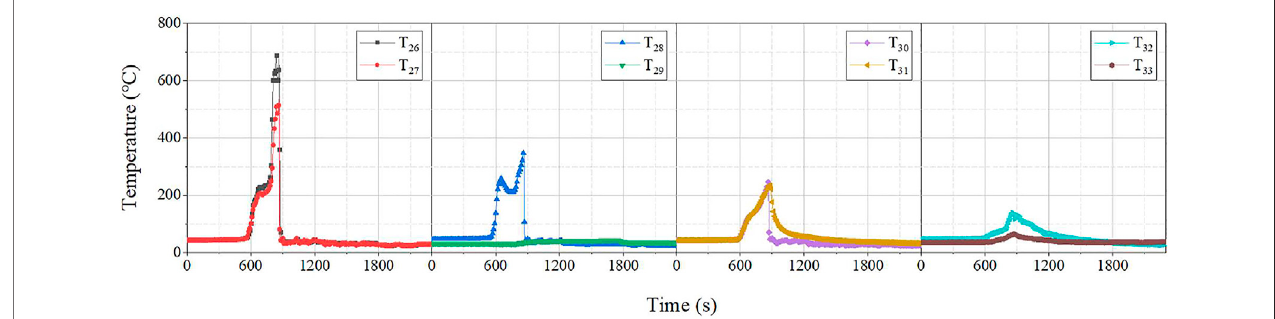
FIGURE 8 | Temperature evolutions in the compartments of PHEV A.